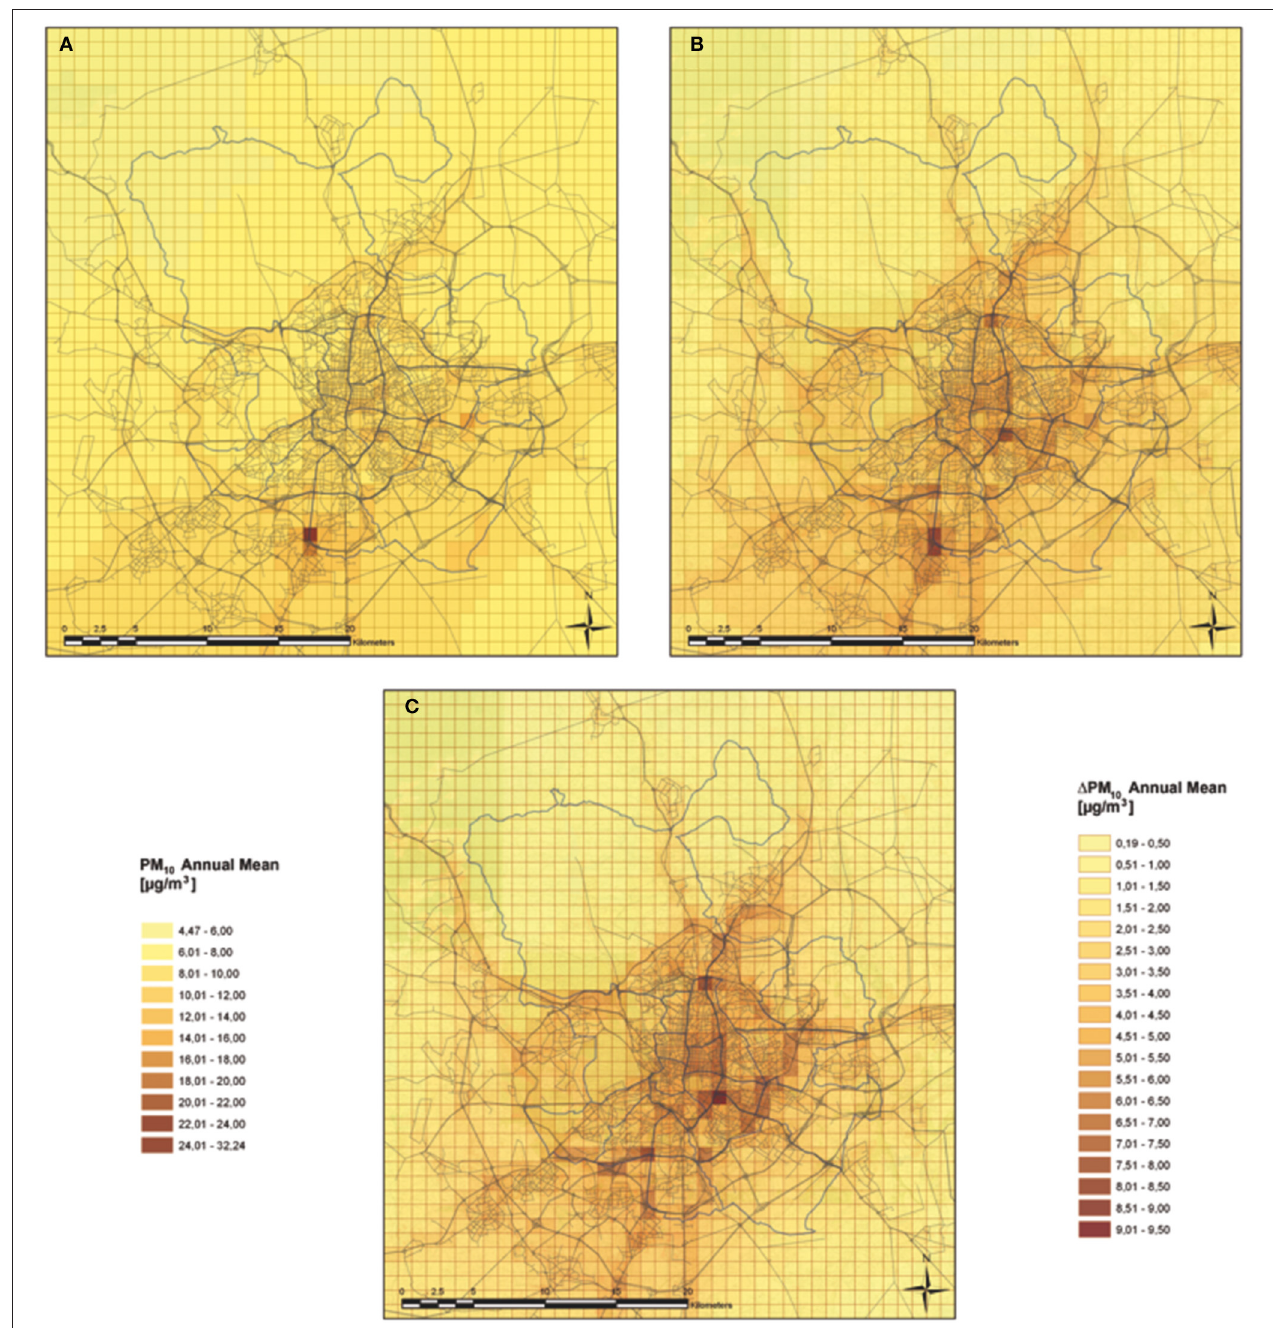
FIGURE 7 | Annual average PM 10 concentrations for CMAQ simulations considering: (A) emissions with resuspension and the effect of rain (B) emissions without resuspension (C) differences between (A) and (B).